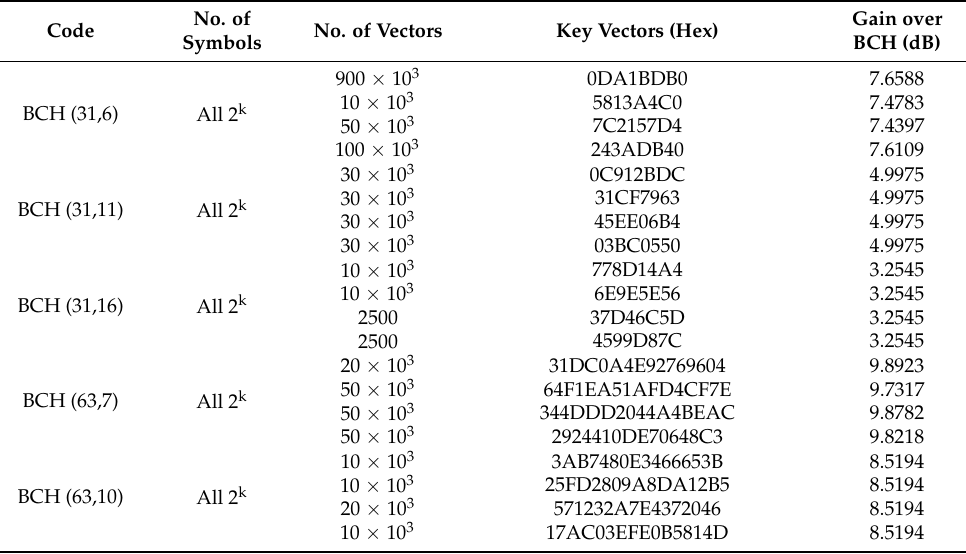
Table 2. Keys selected and gains